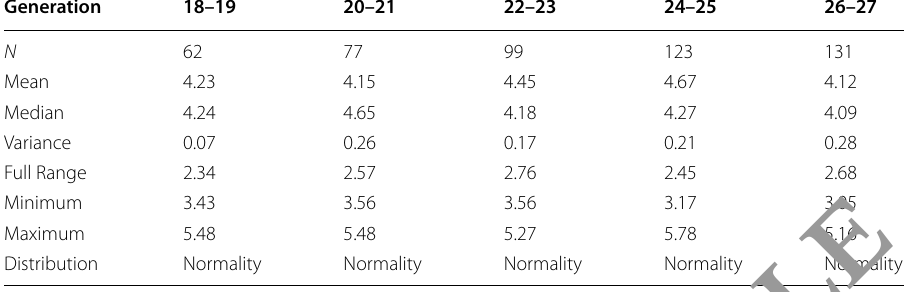
Table 1 Statistics of normal distribution of basketball players’ acceleration Generation